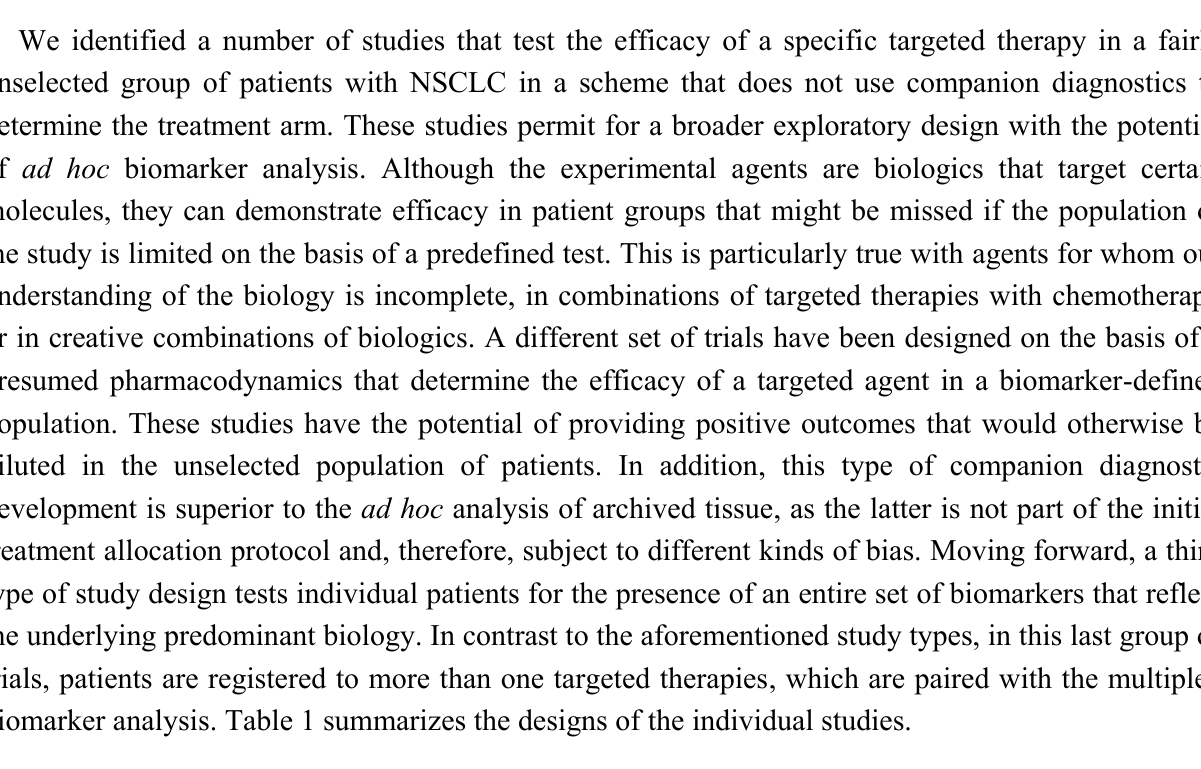
Table 1. Comparative description of study